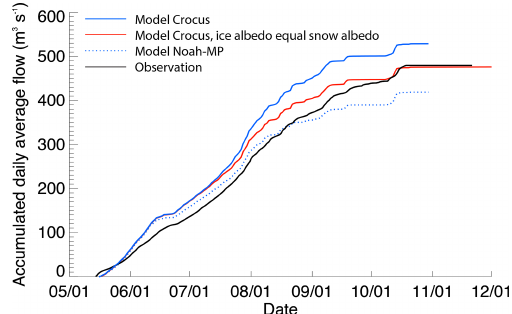
Figure 18. Accumulated stream flow at Middalselvi in 2018. Red is the sensitivity test where snow albedo is used instead of ice